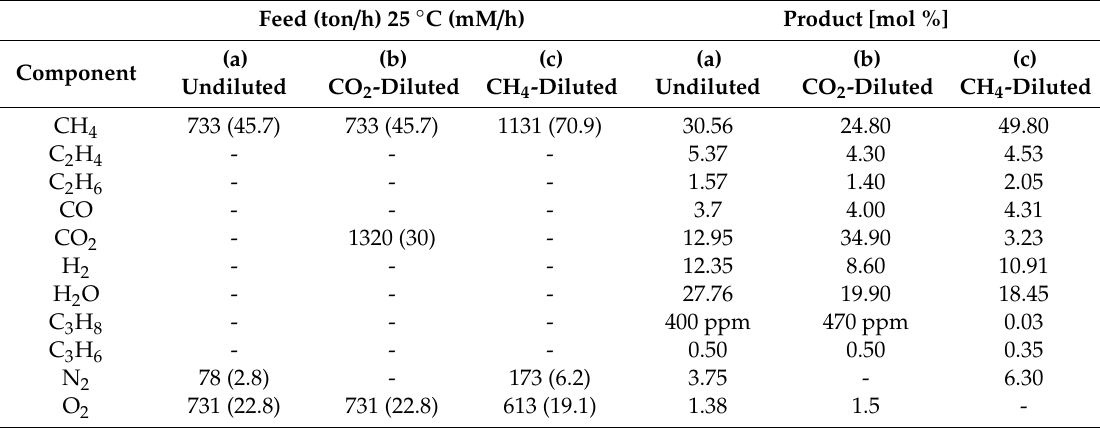
Table 1. The OCM reactor inlet / outlet feed / product stream compositions with three levels and types of dilution: (a) undiluted, (b) CO 2 -diluted, and (c) CH 4